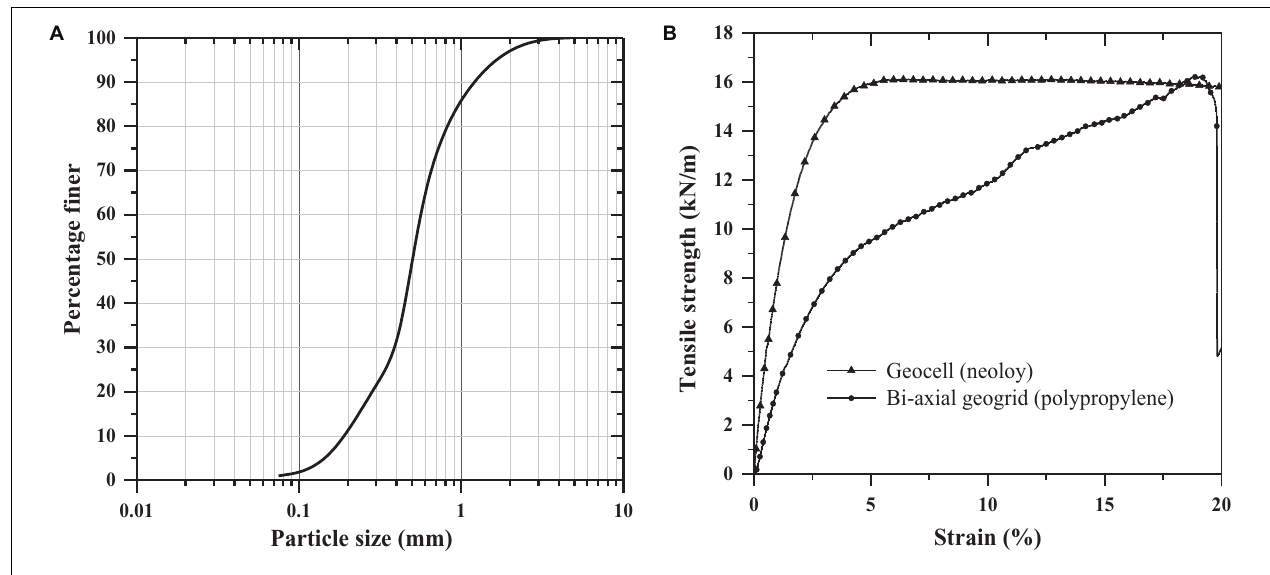
FIGURE 1 | Material properties: (A) grain size distribution of sand; (B) tensile strength of geocell and geogrid.